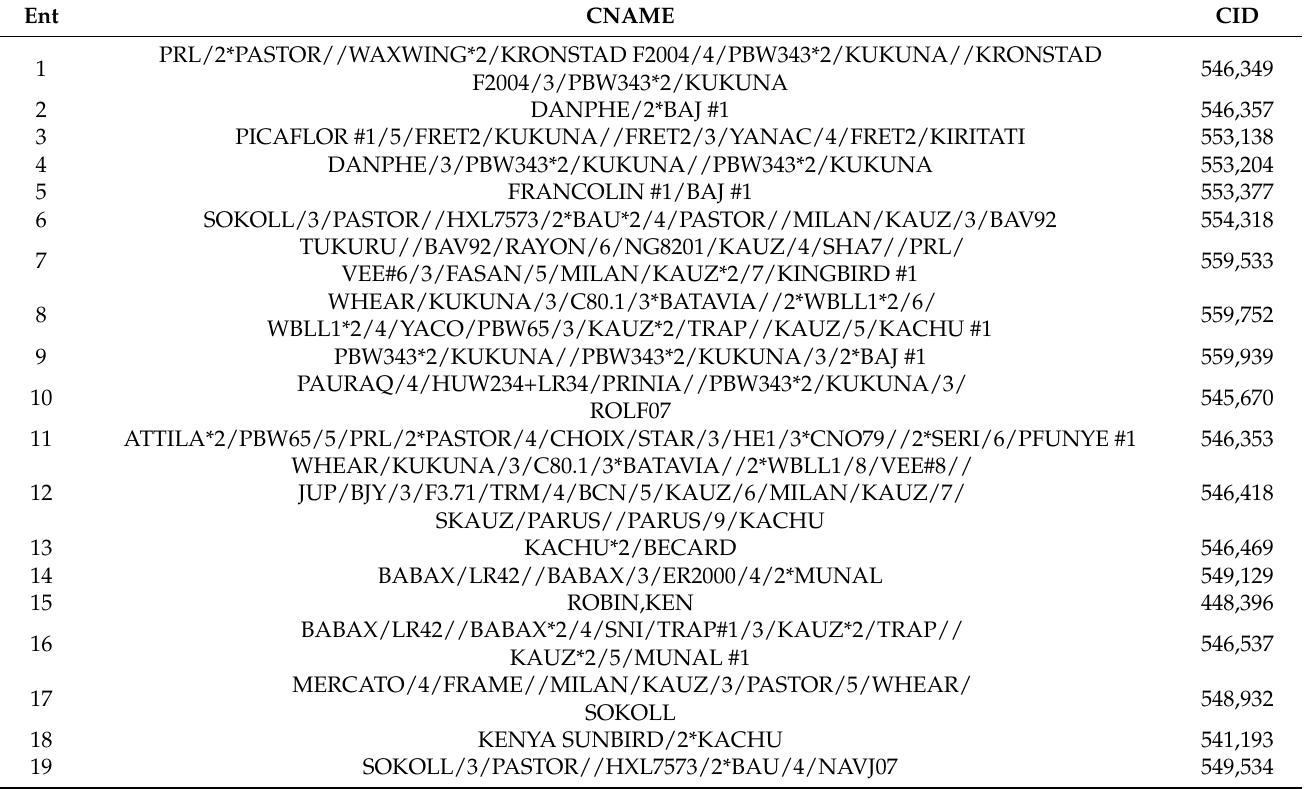
Table 2. The list of the spring wheat germplasm used in the field studies and the six check